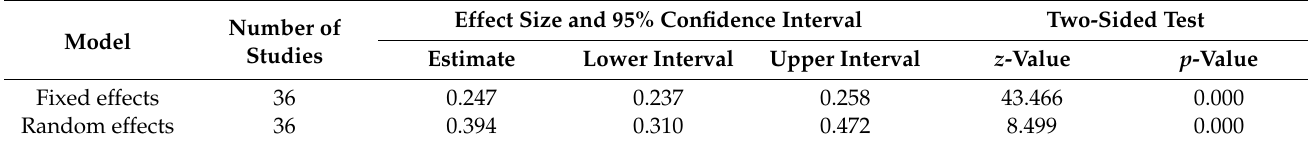
Table 2. Meta-analysis results of sample main